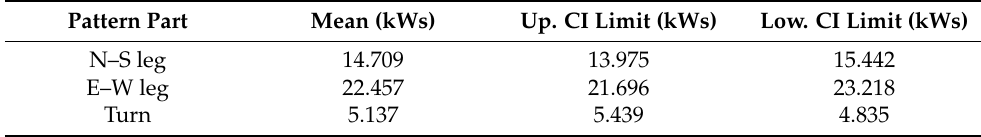
Table 5. Energy consumed by the drone in various maneuvers (real